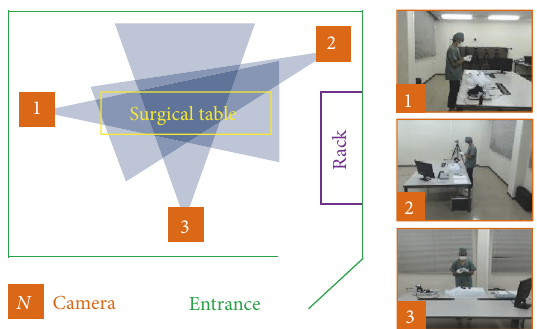
Figure 10: Simulated setting for our experiments, plus sample camera